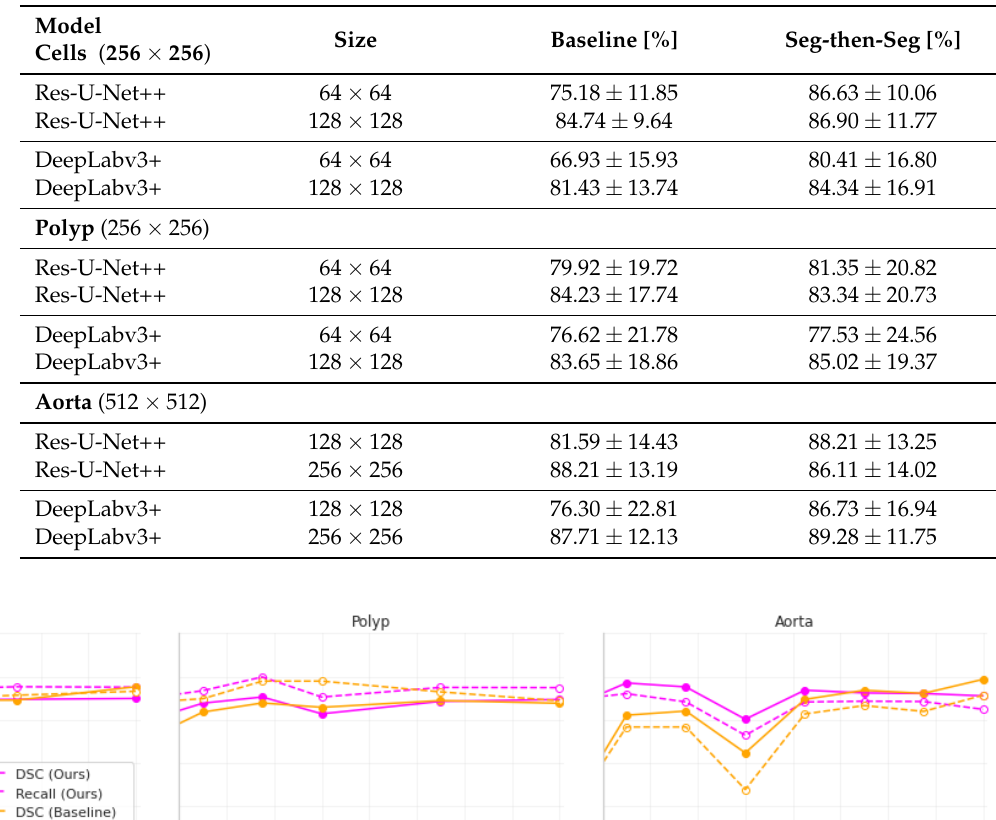
Table 3. A comparison of the Dice Score Coefficients of our approach using other underlying architectures at 4 × and 2 × downscaled images. The complete results of all of our experiments are available in Appendix A.